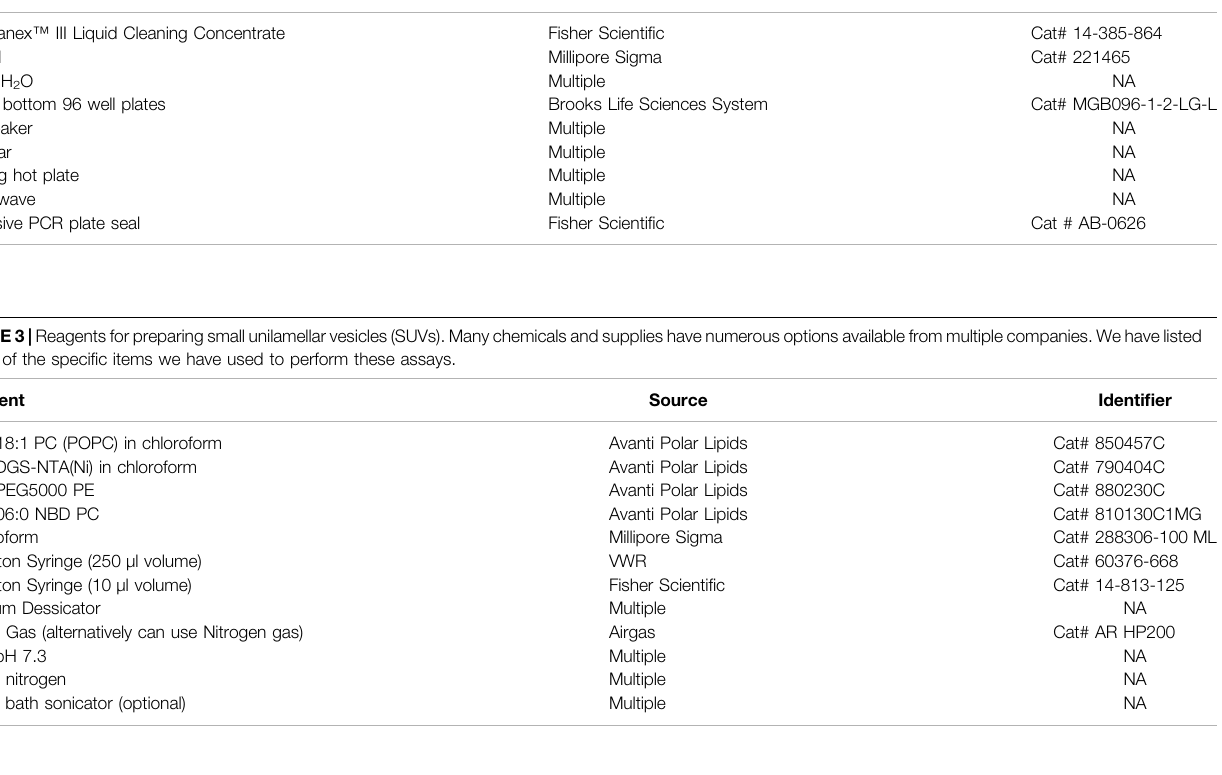
TABLE 4 | Reagents for actin assemblyassay.Many chemicals and supplies havenumerous options available from multiple companies. Wehave listed someofthe speci fi c items we have used to perform these assays. We use actin puri fi ed from rabbit muscle (Doolittle et al., 2013a) and labeled with Alexa-647 C 2 maleimide (Hansen et al., 2013). We use Arp2/3 puri fi ed from calf thymus (Doolittle et al., 2013b). The commercially available alternatives are listed here, but we have not directly tested our methods with these commercial reagents. Reagent Actin ( > 99% pure) from Rabbit Skeletal